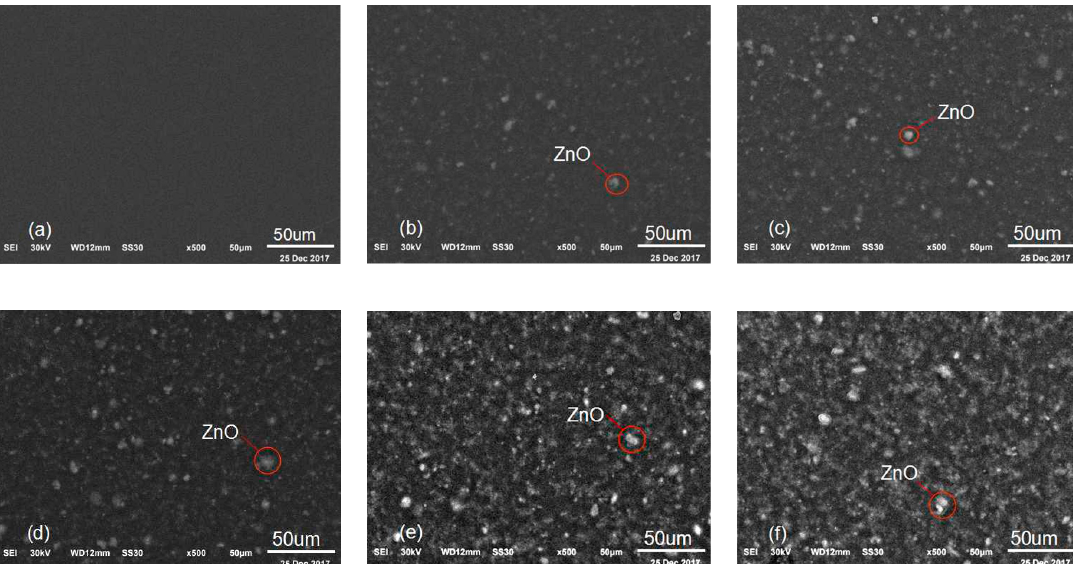
Figure 7. Scanning Electron Microscopy of PVDF-TrFE/nano-ZnO films with different nano-ZnO